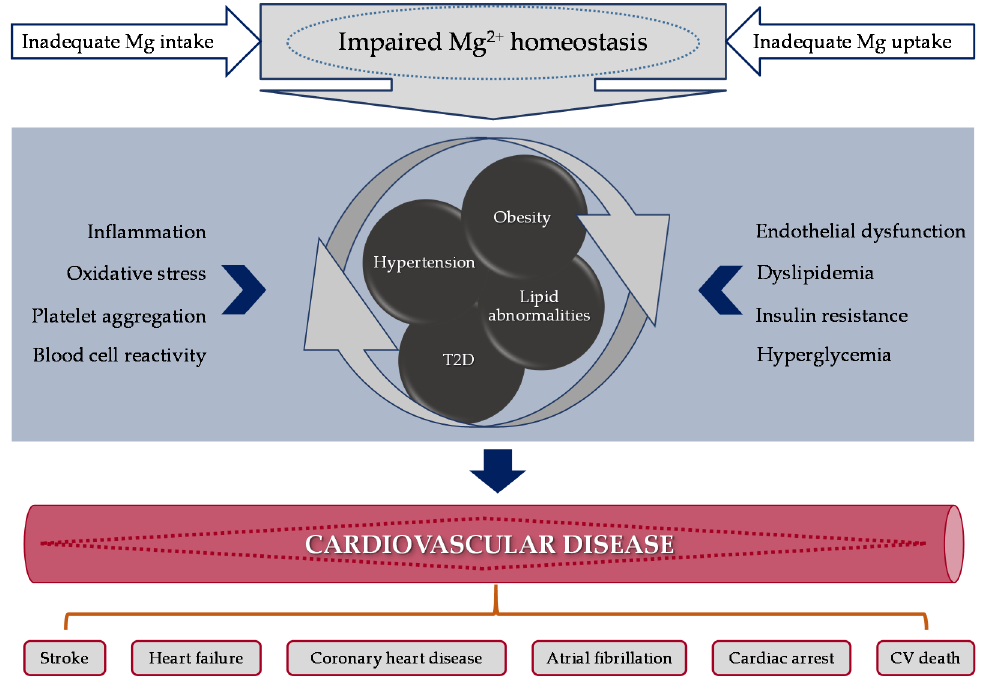
Figure 2. Mechanisms linking magnesium abnormalities (intake or circulating levels) with molecular outcomes leading to CV risk factors that may induce CV disease. Abbreviations: CV, cardiovascular; Mg, magnesium; T2D, type 2 diabetes.